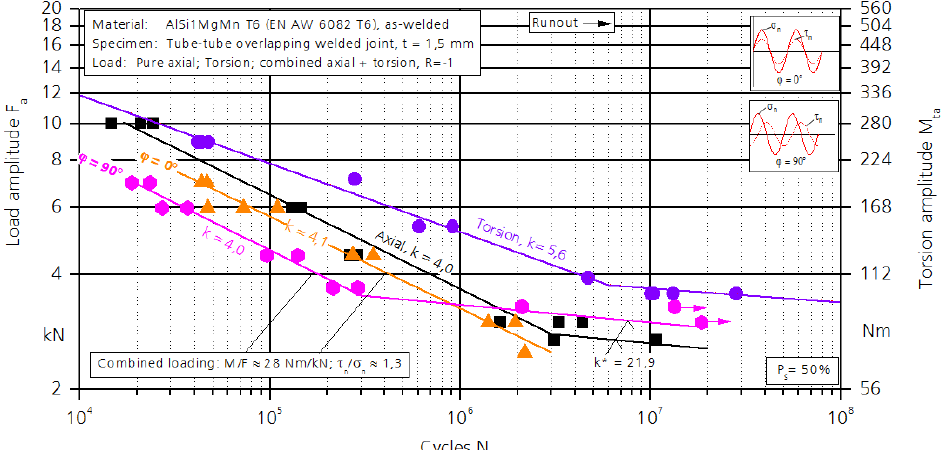
Figure 6: Experimental results for aluminum alloy EN AW 6082 T6 under constant amplitudes